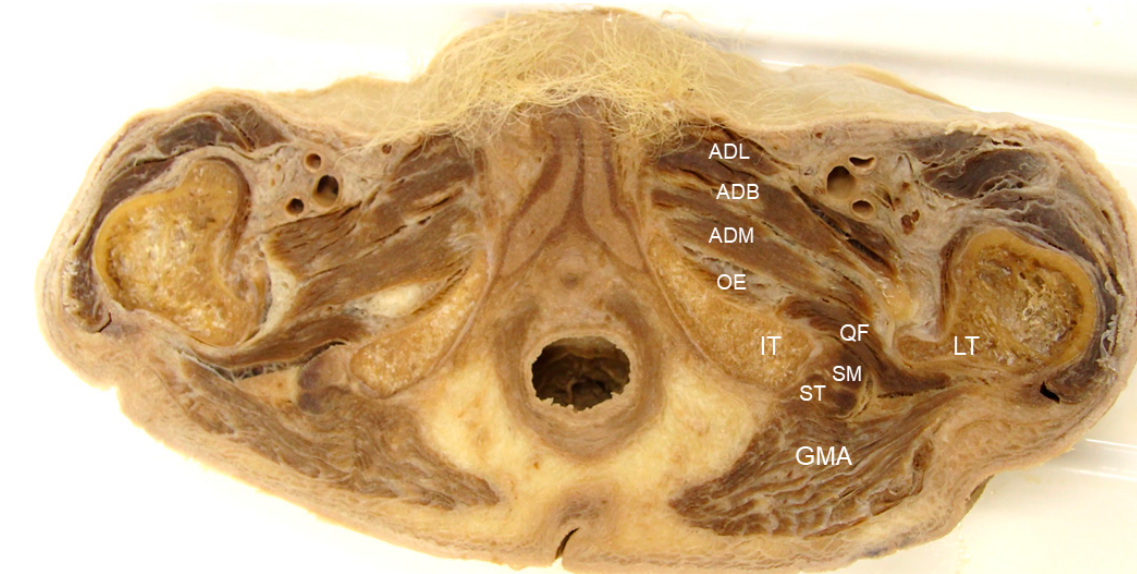
Figure 2. Cadaveric image providing an axial view of the ischiofemoral space. GMA: gluteus maxi- mus muscle; ST: tendon of the semitendinosus; SM: tendon of the semimembranosus; QF: quadratus femoris muscle; OE: obturator externus muscle; LT: lesser trochanter; IT: ischial tuberosity; ADM: adductor magnus muscle; ADB: adductor brevis muscle; ADL: adductor longus muscle.